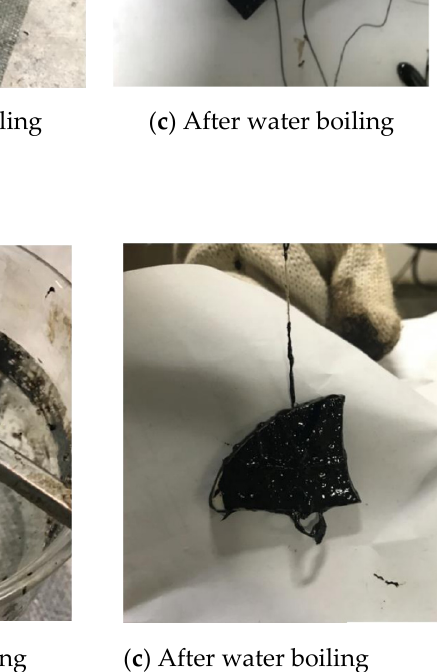
Figure 16. Test pictures of ceramic aggregate.